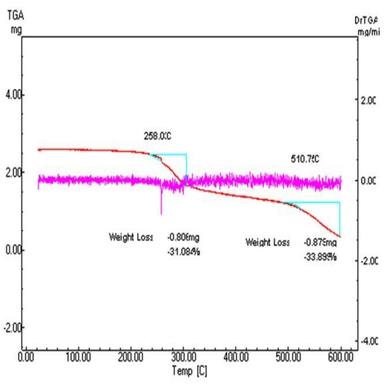
TGA curve of OLZ sample A.